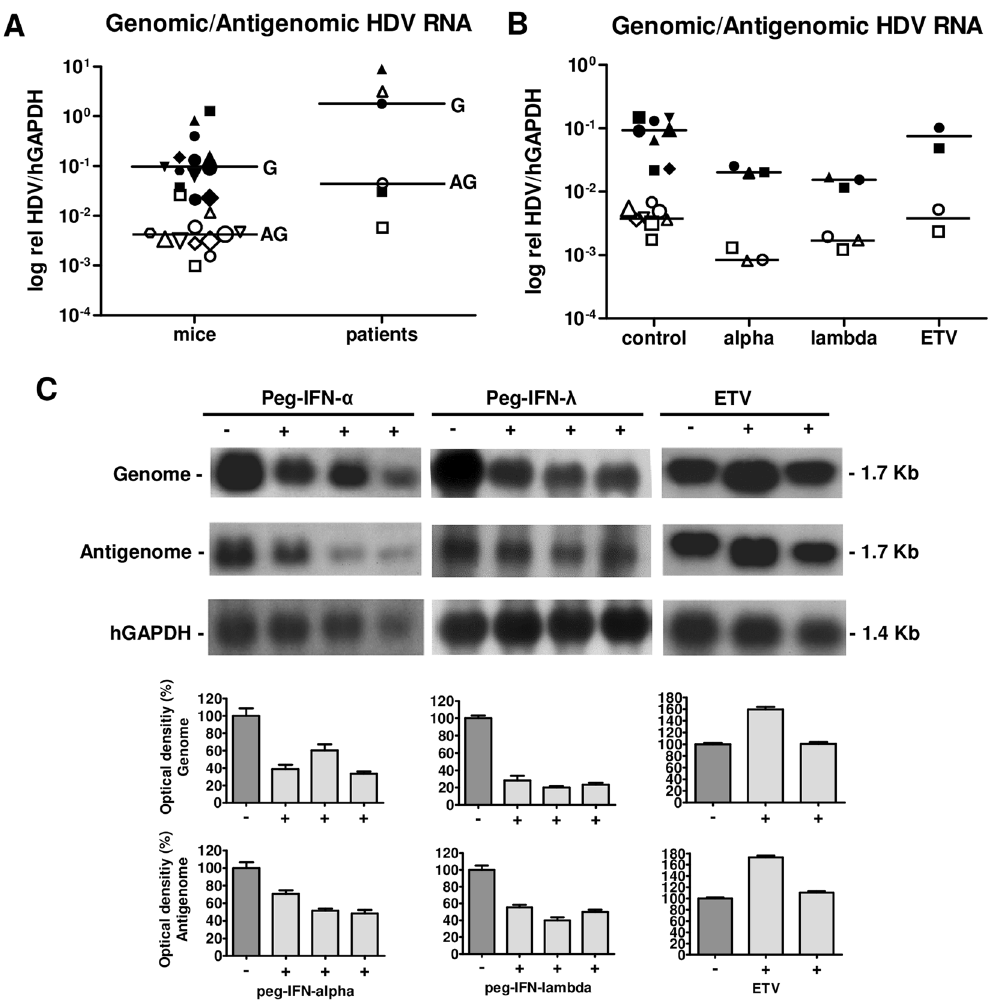
Figure 4. Genomic and antigenomic HDV RNA. Amounts of genomic (black symbols) and antigenomic (white symbols) HDV RNA detected with the novel BMB qRT-PCR assay are similar in patients liver biopsies (n = 3) and humanized USB mice (n = 13) ( A ). Peg-INF α (n = 3) and peg-INF λ (n = 3) treatment reduced amounts of genomic (black symbols) and antigenomic (white symbols) HDV RNA relative to hGAPDH clearly, while ETV (n = 2) did not show a reduction of HDV RNA levels compared to untreated control mice (n = 8) ( B ). Same symbols within one group (e.g. circle, triangle) represent distinct values of the same mouse/patient ( A, B ). ( C ) Shows representative northern blot analyses and their densitometric quantification of signal bands for genomic (1.7 kb) and antigenomic HDV RNA (1.7 kb) from untreated, peg-IFN α , peg-INF λ and ETV treated